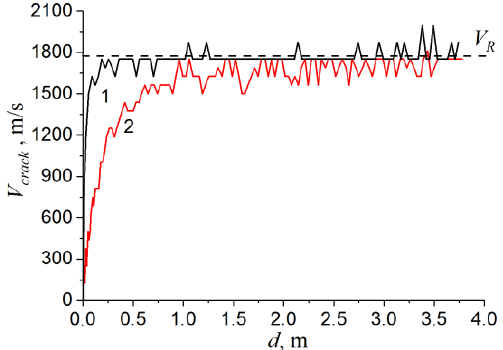
Fig. 2. The crack tip propagation velocity V crack dependences on the crack tip path length d for the cases of infinitely small fracture incubation time (curve 1) and finite fracture incubation time (curve